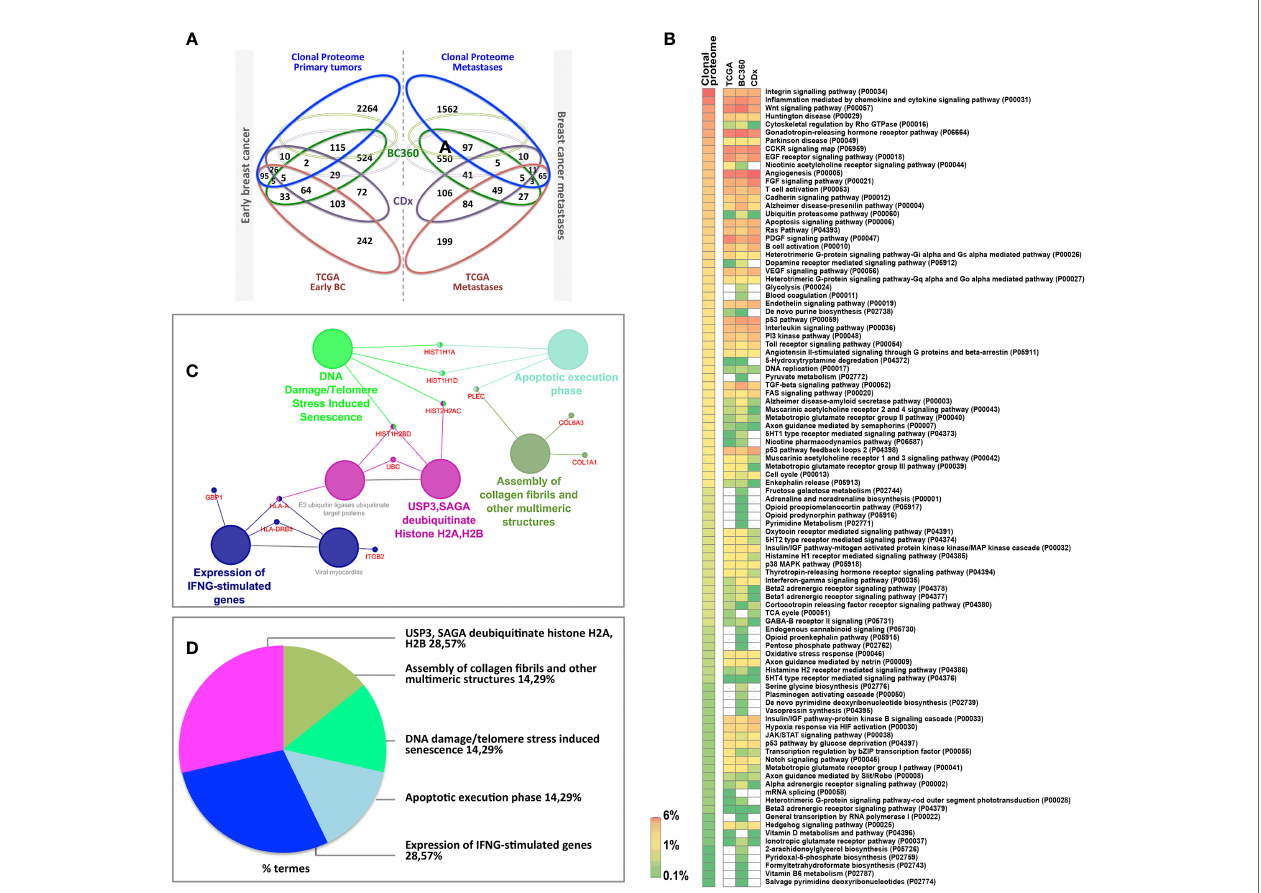
FIGURE 3 | (A) Venn diagram comparing the clonal proteome dataset with TCGA, BC360 and CDx panels, in primary breast cancer (left) or metastases (right). (B) Panther pathways heatmap showing gene distribution between the datasets. Pathways over-represented are colored in orange and those underrepresented in green. (C) Mutated protein networks and (D) biological processes distribution analyzed using Cytoscape and